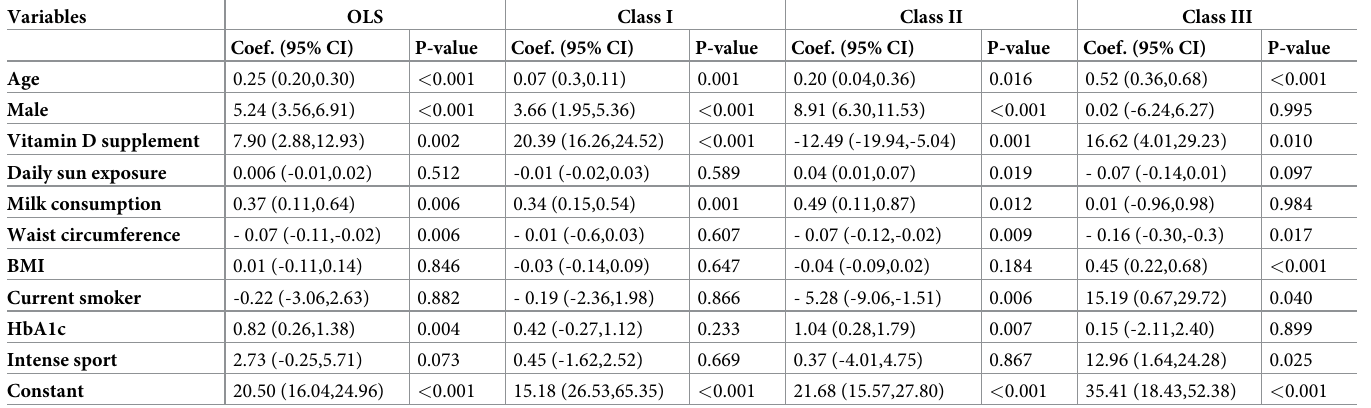
Table 2. Results of linear regression coefficient and FMM classes (n = 2,641).